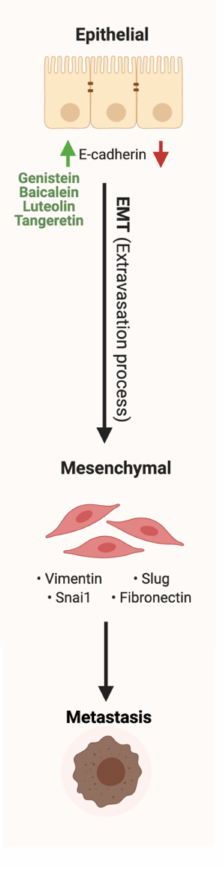
Figure 6. Schematic illustration of the impact of flavonoids on metastasis and EMT pathway. Red arrows represent the effects of GI cancer on the pathway, while the green arrows illustrate the impact of flavonoids on the pathway. Created with BioRender.com (accessed on 3 August